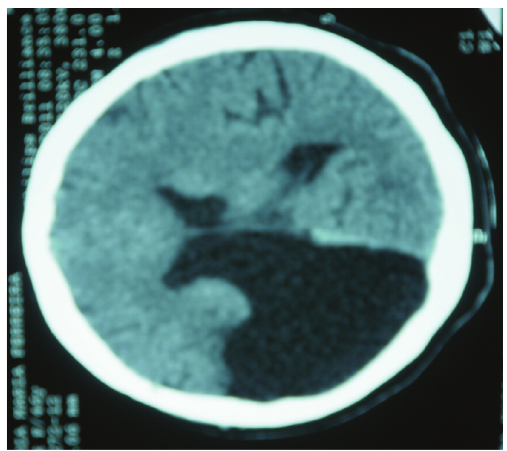
Figure 1: Head CT scan (October 4,